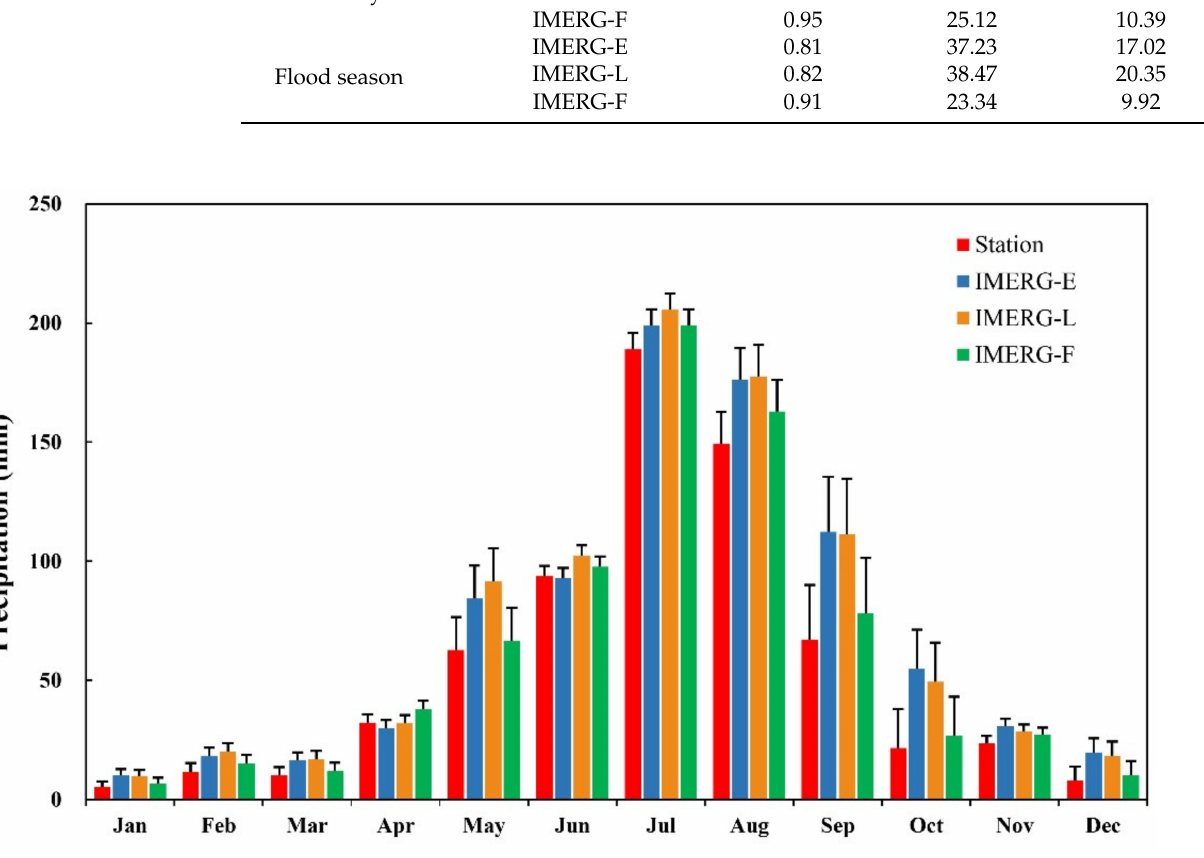
Figure 3. Average monthly precipitation from land stations and IMERG